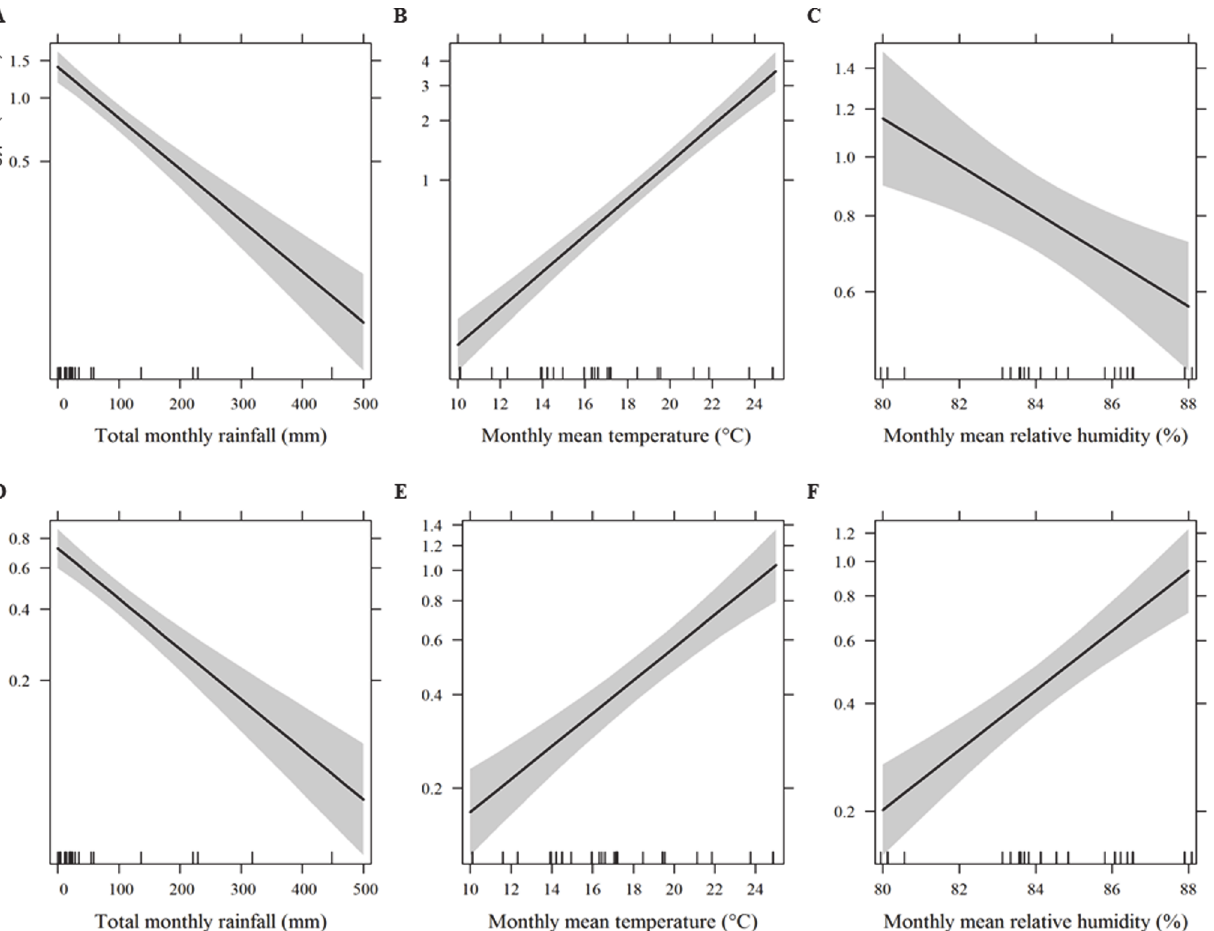
Fig 3. Effects of climate variables on the abundance of larvae of vector mosquitoes. Panels A, B and C show the effects of monthly total rainfall (mm), mean temperature (°C) and relative humidity (%), respectively, on the abundance of Aedes aegypti per container. Panels D, E and F show the effects of monthly total rainfall (mm), mean temperature (°C) and relative humidity (%), respectively, on the abundance of Aedes albopictus per container. Mosquito abundances are displayed in log